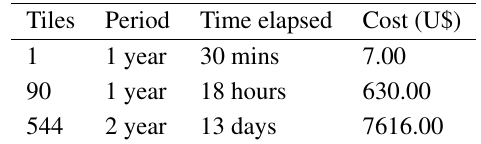
Table 1. Time elapsed and cost to produce EO data cubes using the Data Cube Builder on